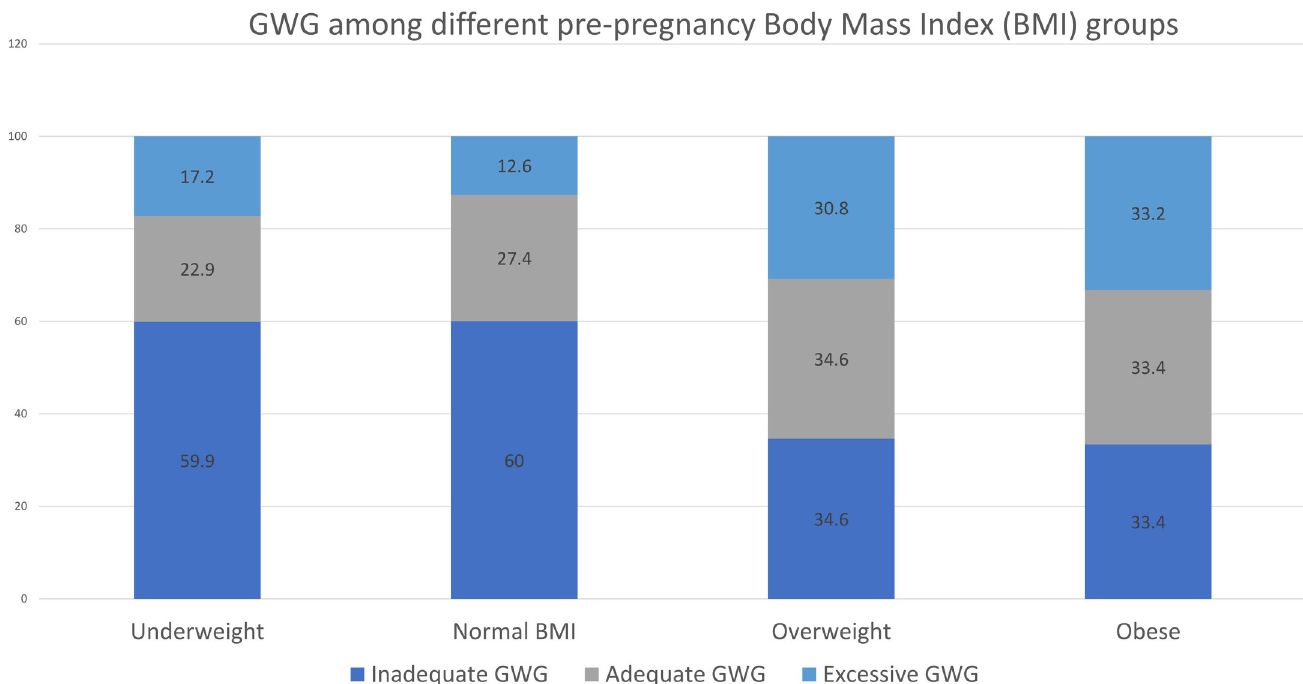
Fig 1. Distribution of gestational weight gain according to institute of medicine among various prepregnancy body mass index groups.